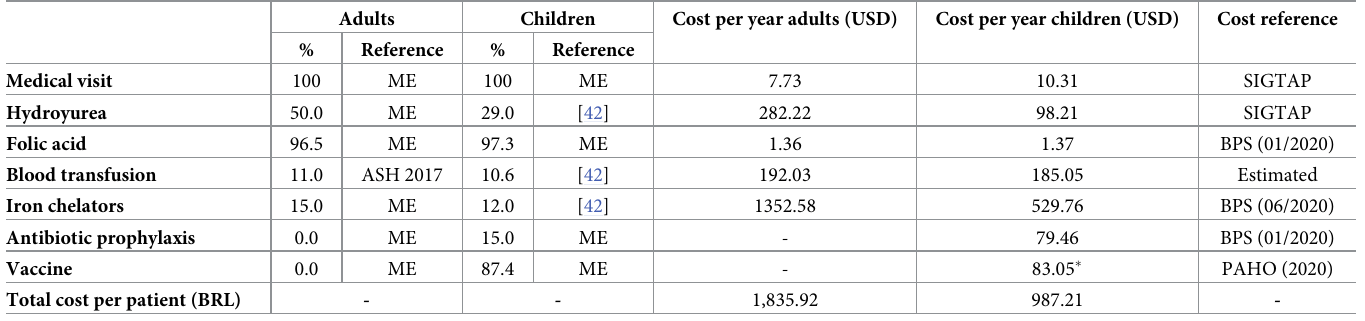
Table 2. Standard of care cost.